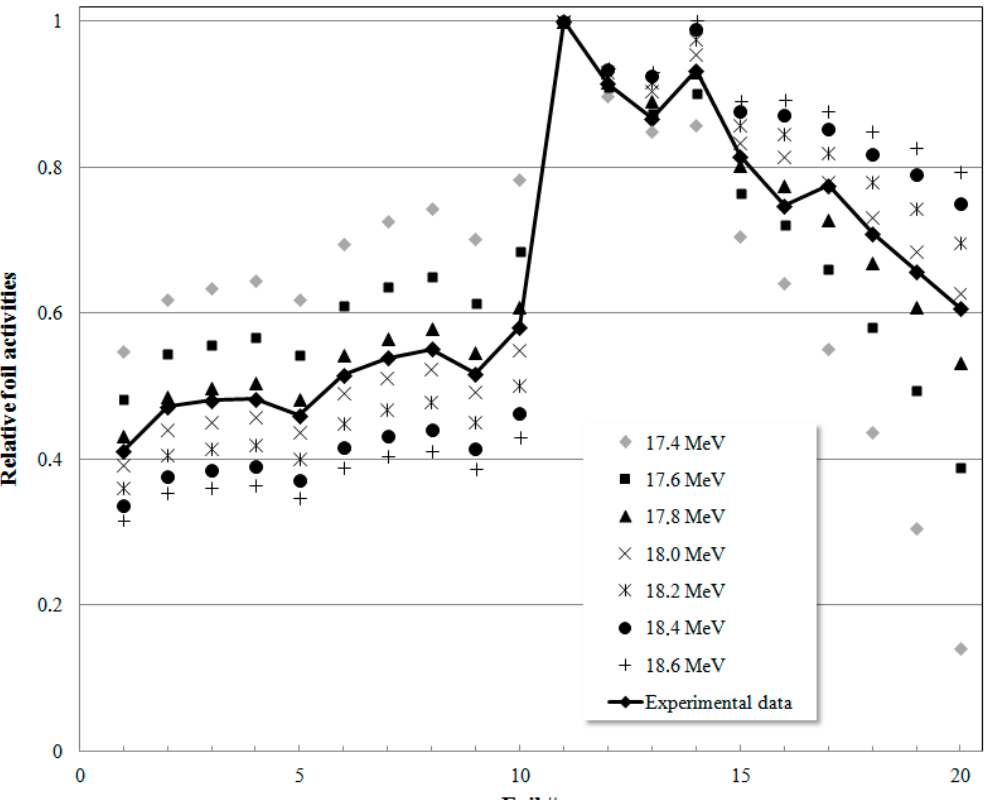
Figure 2. Calculated relative activities in the 20 foils of the stack, for several impinging energies for a typical experiment (symbols without line) and respective experimental data (full line). The beam crosses the stacks travelling from foil #1 to foil #20. The experimentally determined beam energy in this particular case was 17.900 MeV.